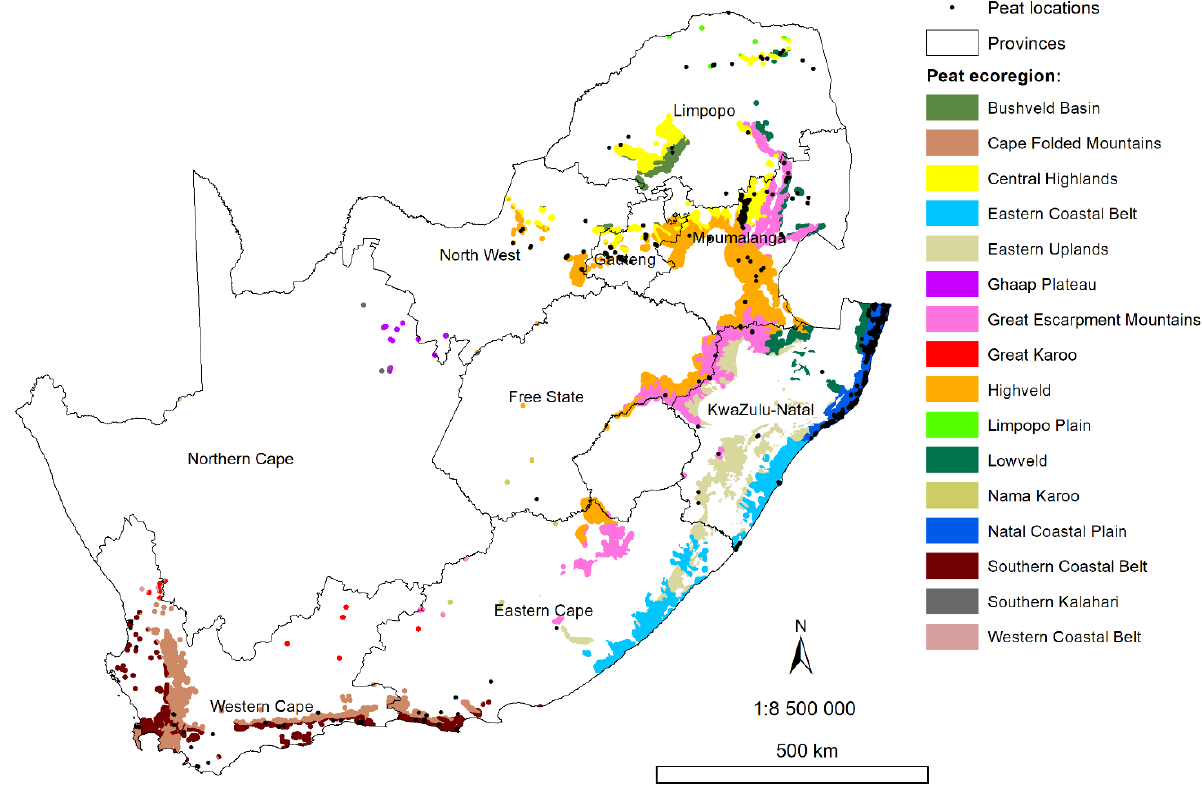
Figure 1. The distribution of 635 confirmed peat locations from the South African National Peatlands Database, used to inform modelling of the extent of peat ecoregions (Grundling et al.